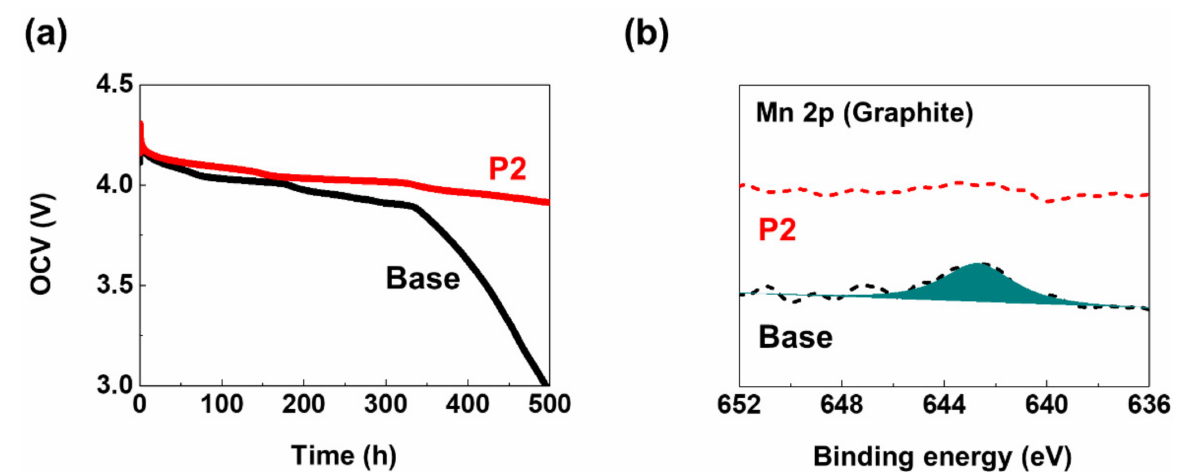
Figure 4. ( a ) OCV variation with time of LMO/graphite cells with the base and P2 electrolytes stored at 60 ◦ C. ( b ) XPS Mn 2p spectra for the graphite electrodes after stored in the base and P2 electrolytes for 48 h at 60 ◦ C. Dotted lines denote the experimental spectra and solid lines denote the best-fitted results.